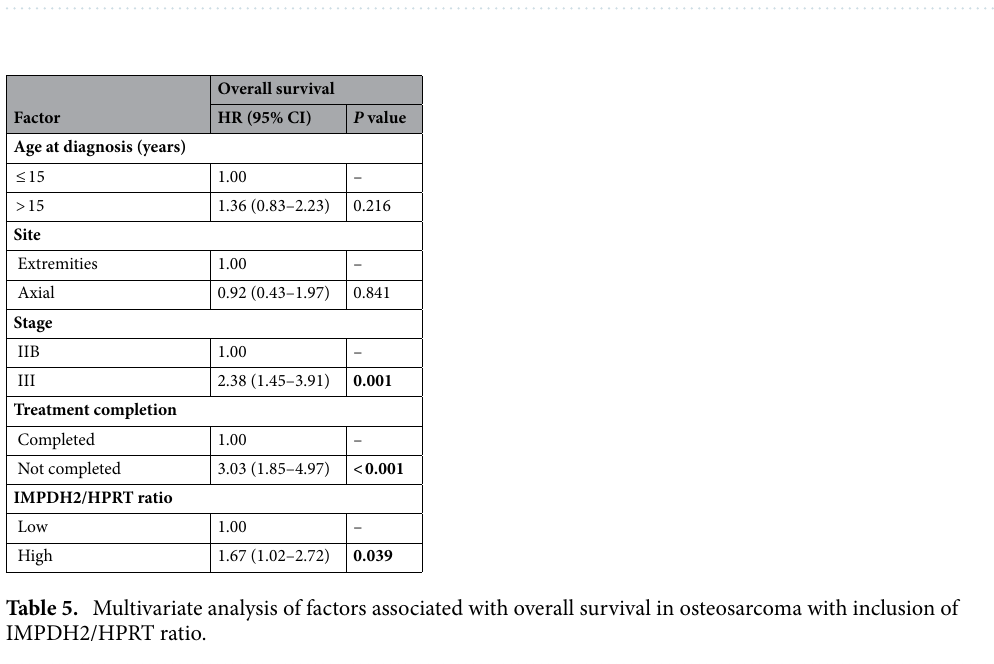
Table 4. Multivariate analysis of factors associated with overall survival in the osteosarcoma cohort with inclusion of HPRT expression.